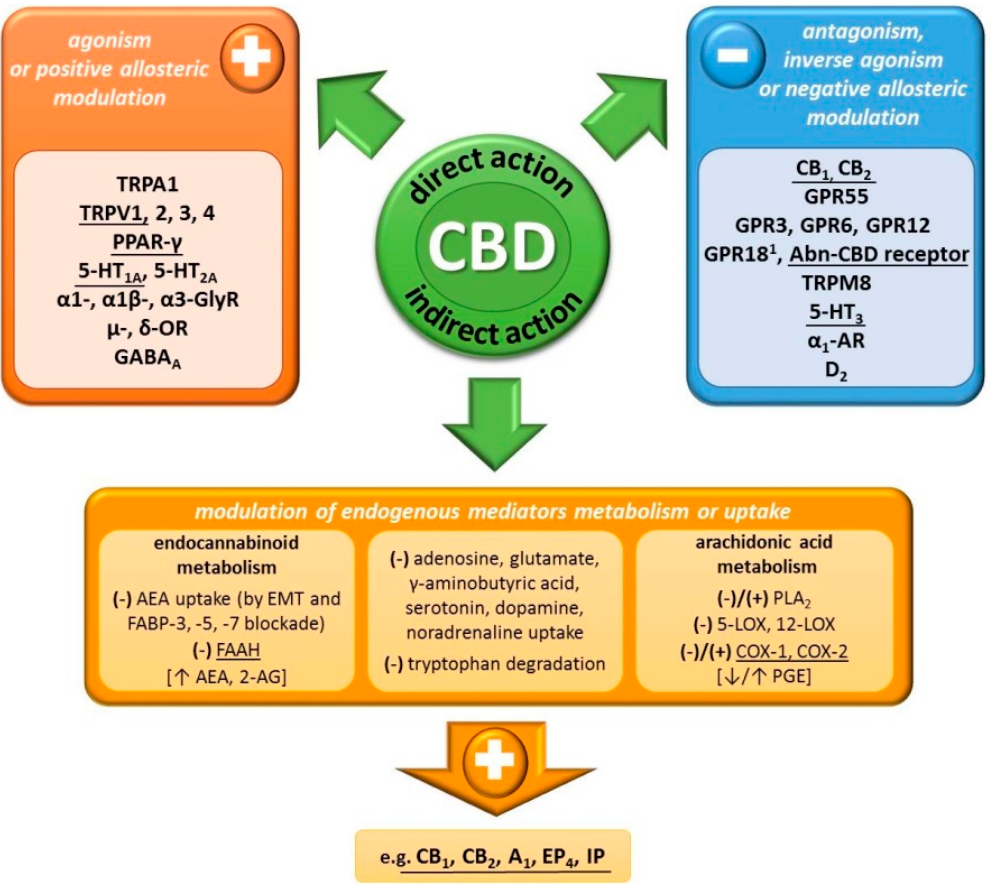
Figure 2. Cannabidiol (CBD) mechanism of action [8–17,21,22,26,27,45,46]. The mechanisms through which CBD exerts its effects in the cardiovascular system are underlined [23,30,47–57]. 1 CBD is